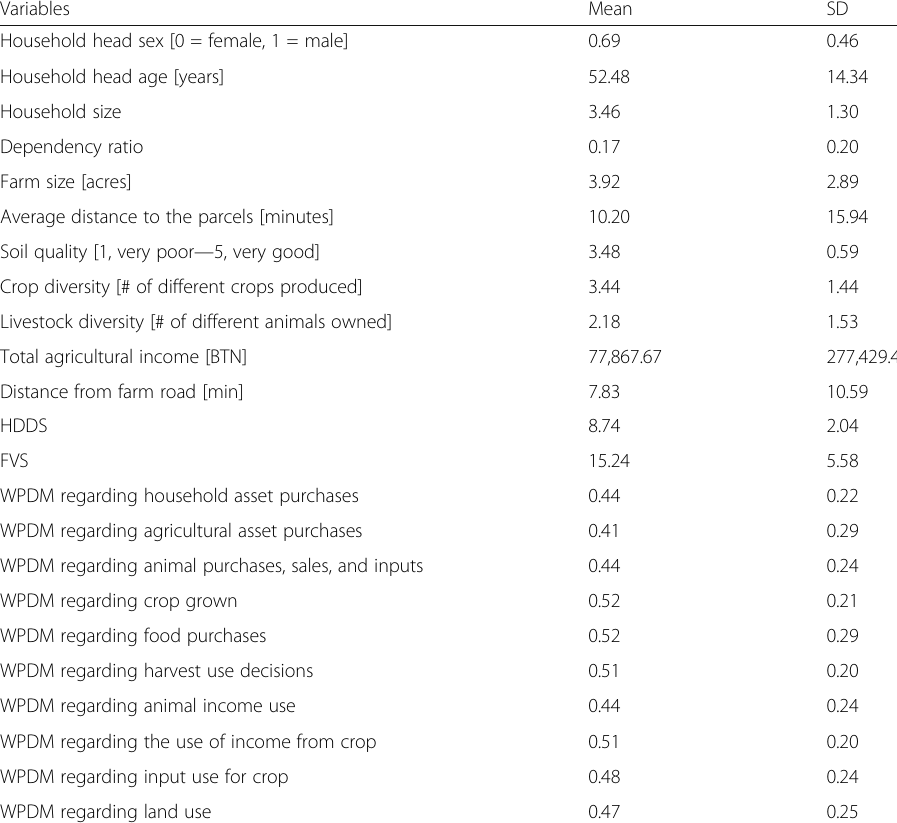
Table 1 Descriptive statistics of the sample households Variables Mean